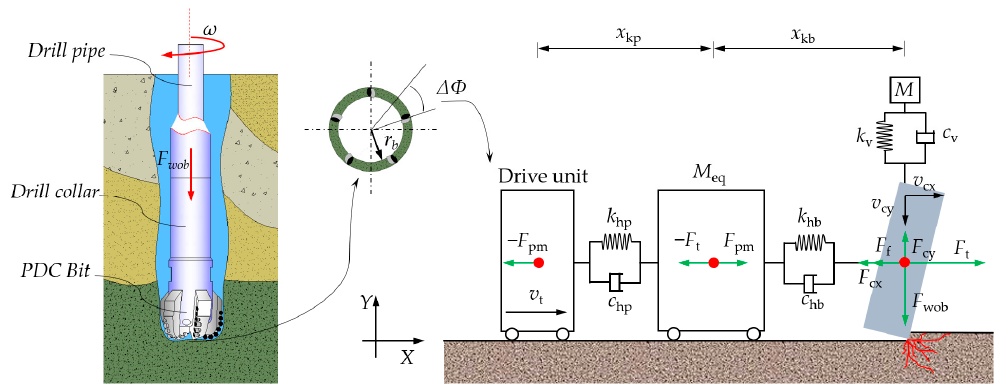
Figure 10. Schematic of the load state of the PDC bit and the cutter during drilling.